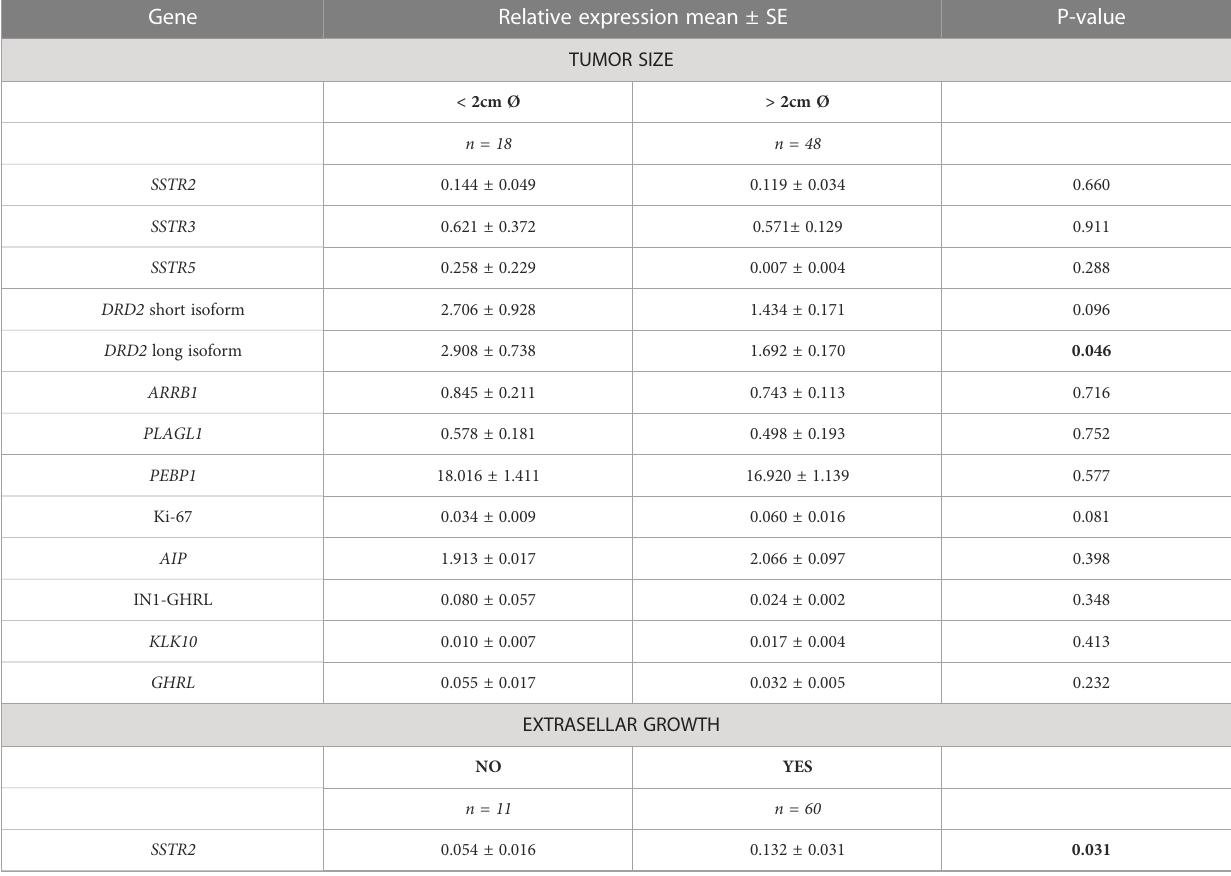
TABLE 3 Association between the relative expression of each SRLs response marker and different tumor characteristics.